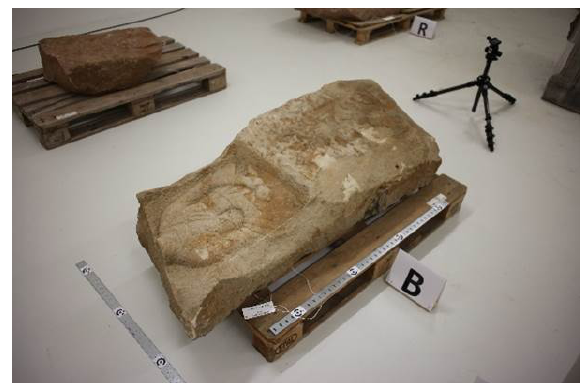
Figure 4: Block-park in Sparsbach